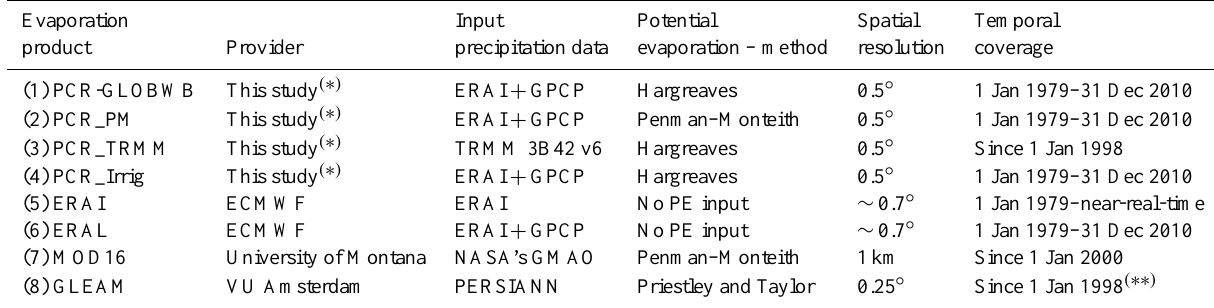
Table 1. Summary of African evaporation products used in this